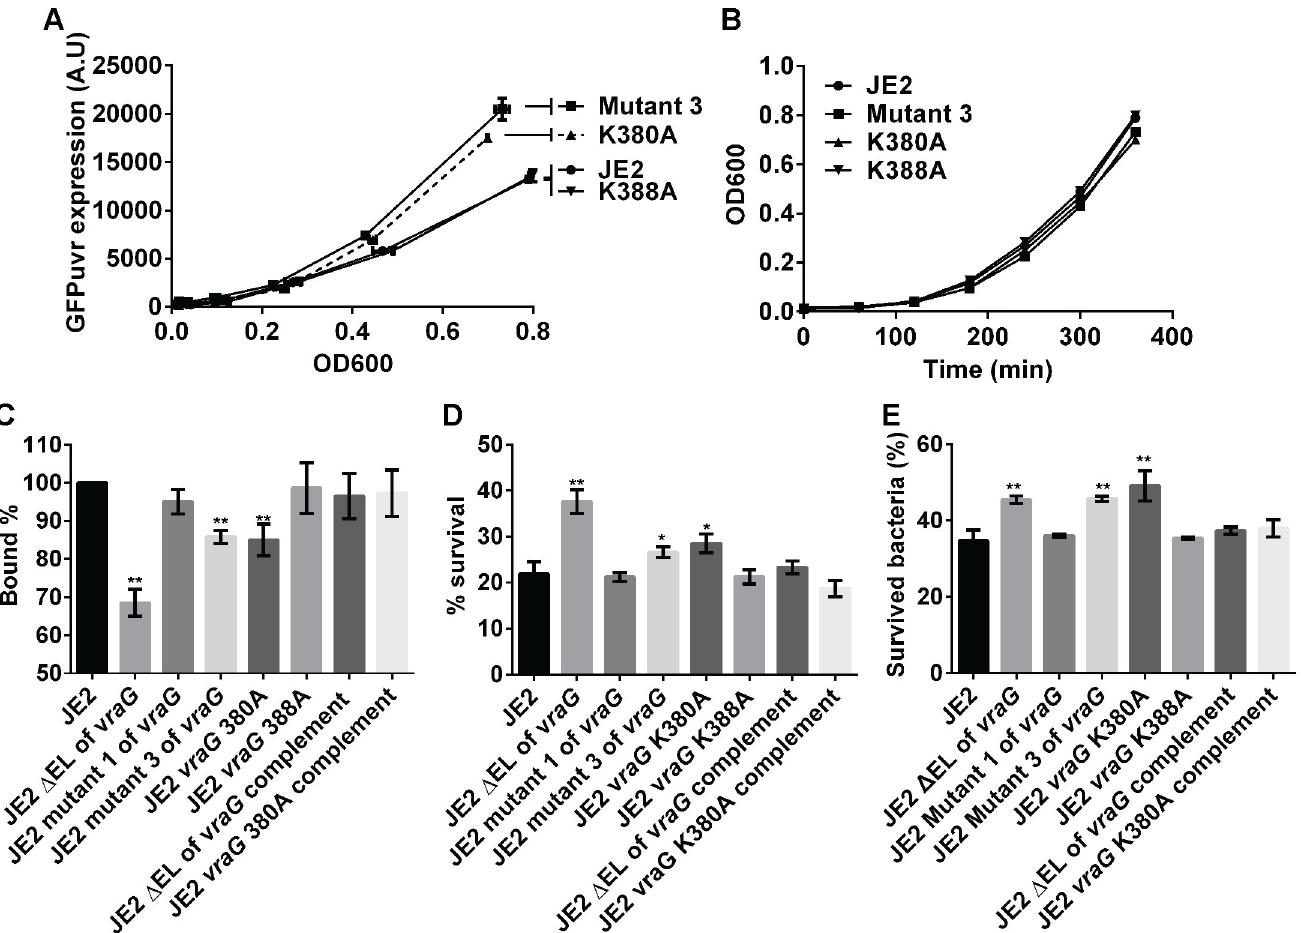
Fig 4. Lysine 380 of VraG interferes with GraS-mediated signaling of HDPs. (A) The expression of mprF promoter fused to the GPFuvr reporter. (B) Cell growth at OD 600 . (C) Cytochrome c binding assay. (D) 2 hr. LL-37 susceptibility assay. (E) PMN assay. These assays were performed, as previously described. Mutant 3 indicates the double mutant (K380, and K388A). Mutant 1 (K327, 331 and 343A) was randomly chosen as a negative control in lysine mutants. The asterisks � and �� for C , D and E indicate p < 0.05 and < 0.01 vs. the wild type, respectively, using the Student-t tests.